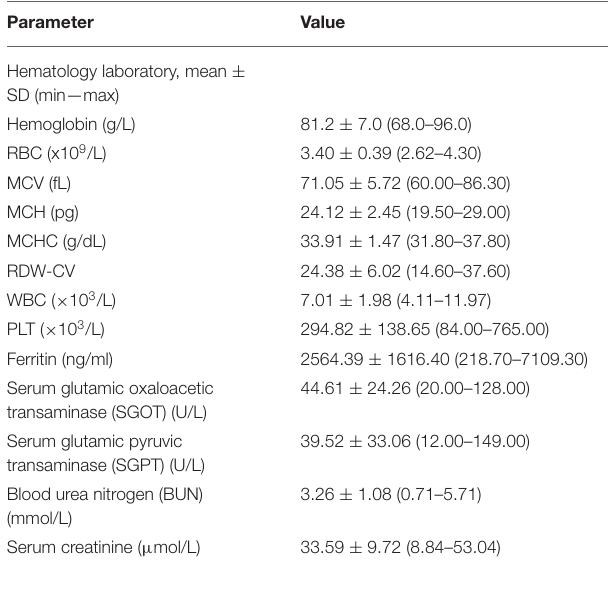
TABLE 2 | Results of hematology, liver function test (LFT), ferritin, and renal function test (RFT) of all 33 patients.